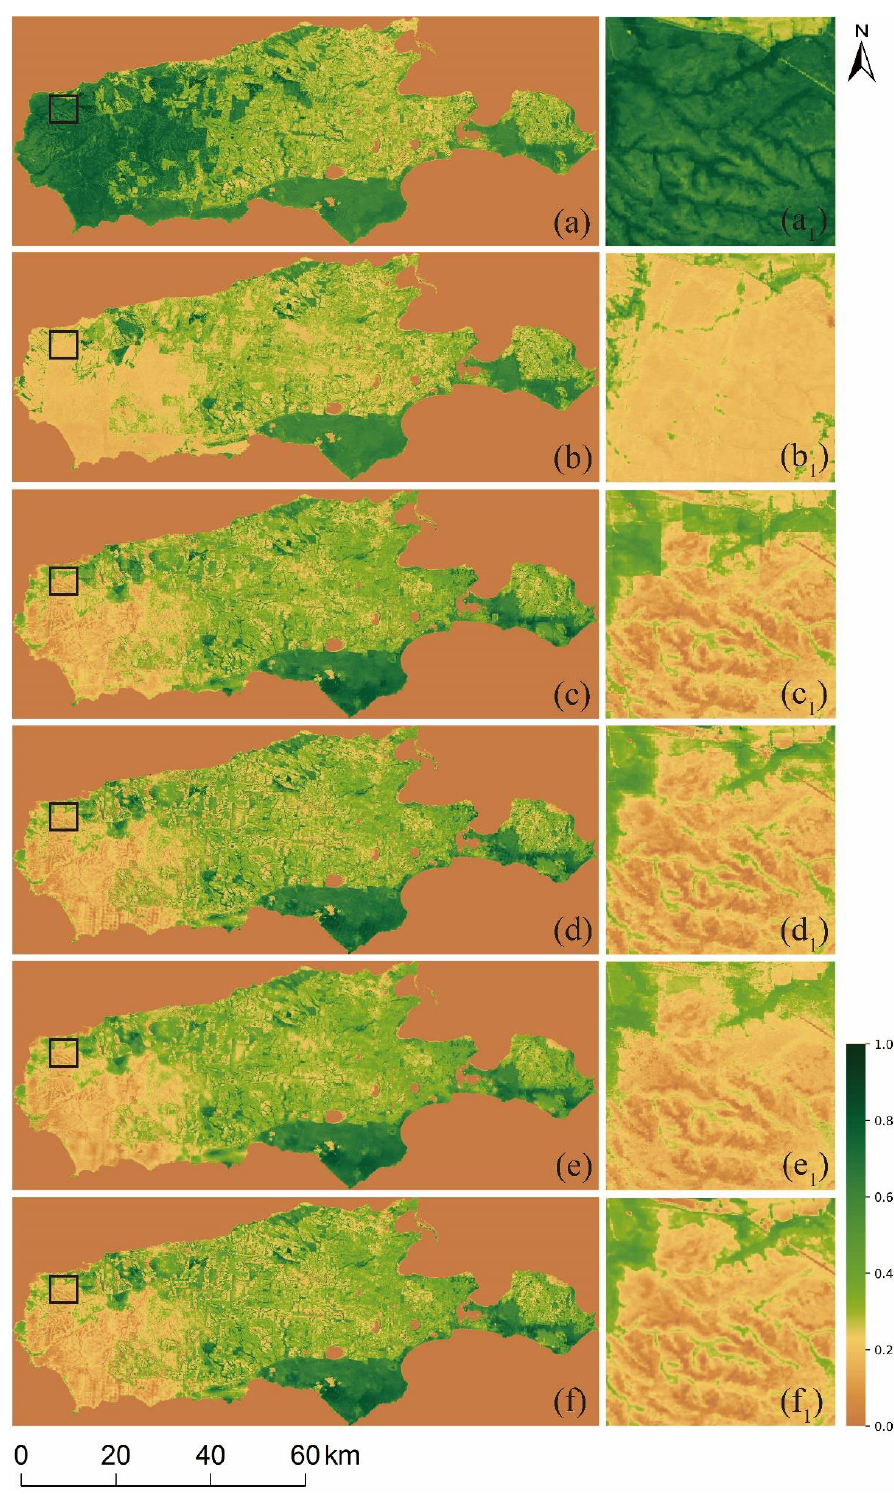
Figure 15. Visual comparison of the fire area. ( a , b ) and ( a 1 , b 1 ). Original Landsat_NDVI and inset map on 22 January 2019 and 10 February 2020; Predicted Landsat_NDVI ( c – f ) and its inset map ( c 1 – f 1 ) by ESTARFM, NDVI-LMGM, FSDAF and NDVI_FMHC.